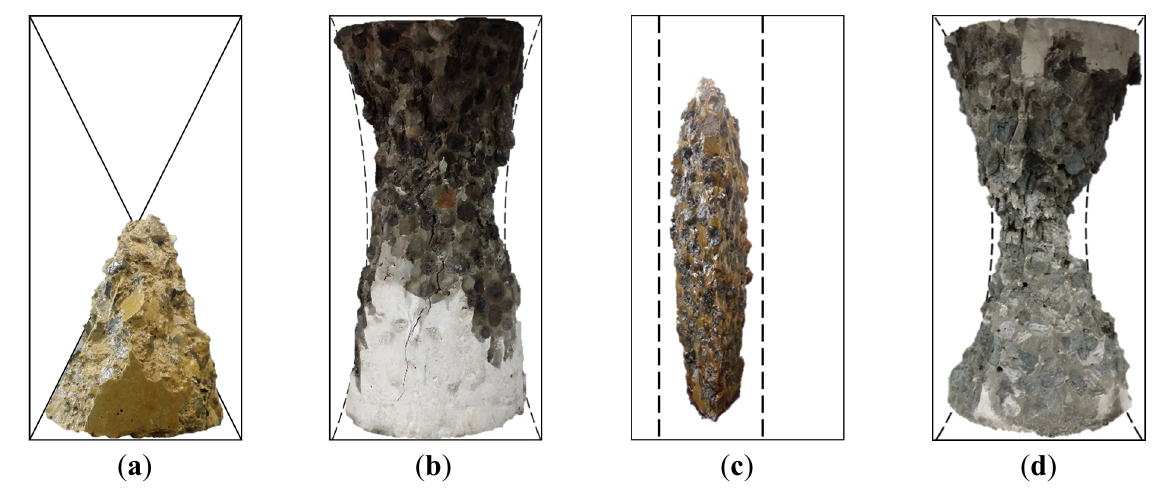
Figure 8. Failure mode: ( a ) normal concrete; ( b ) one with P2; ( c ) the other with P2; and ( d )